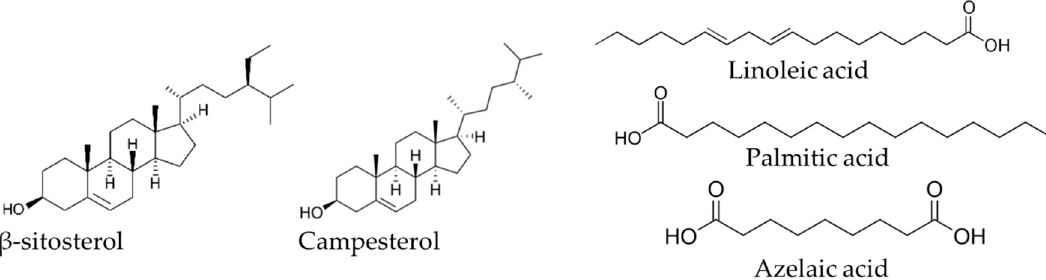
Figure 3. Major lipophilic compounds detected in Algerian Opuntia ficus-indica root extracts. Long-Chain Aliphatic